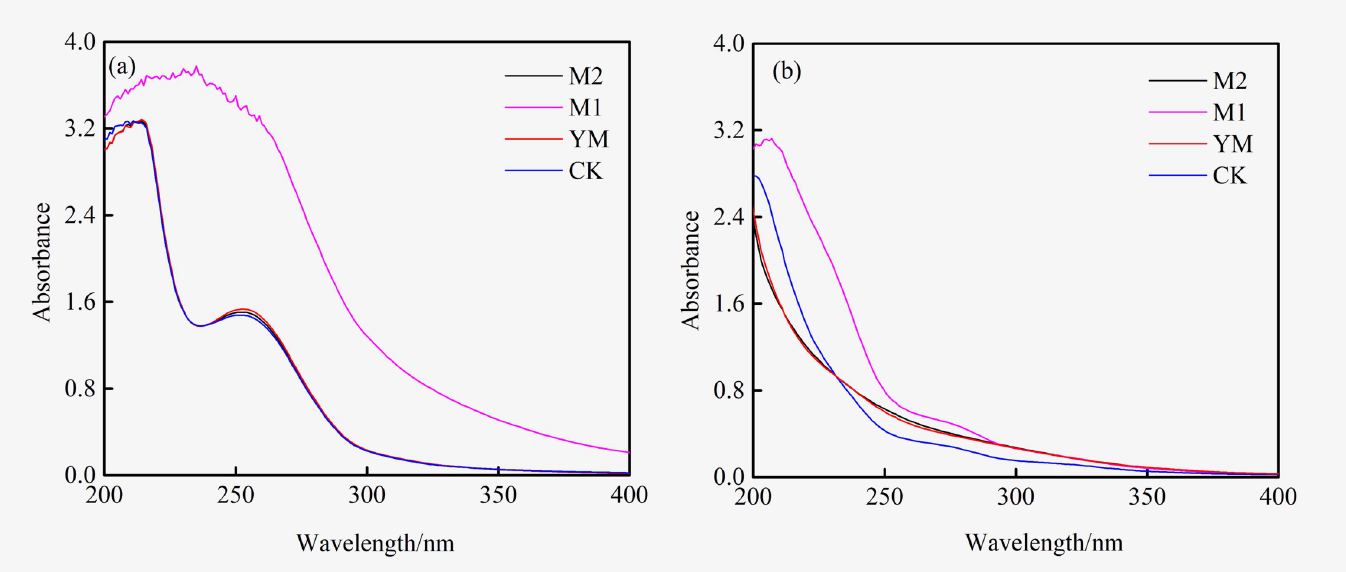
Fig 3. UV-vis analysis of fermentation liquid before and after biogenic methane production.